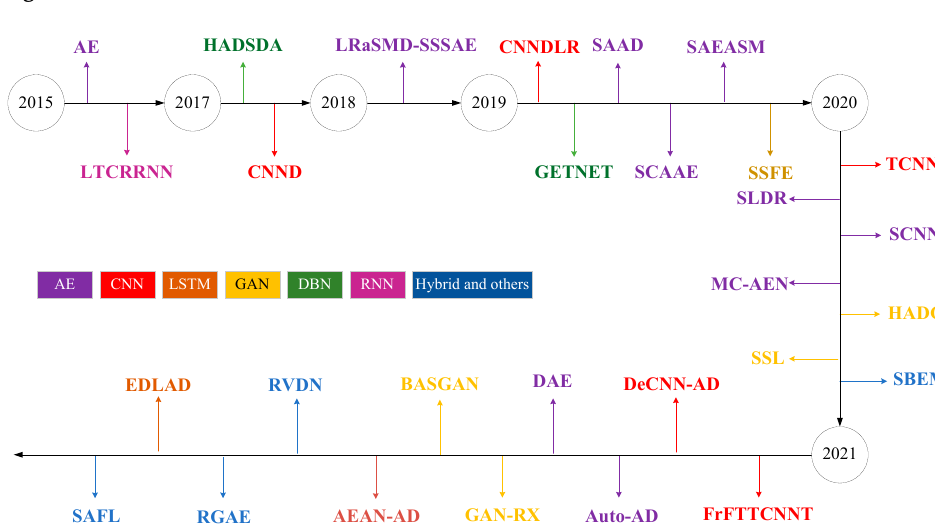
Figure 2. The HSI-AD method based on deep learning distributed in chronological